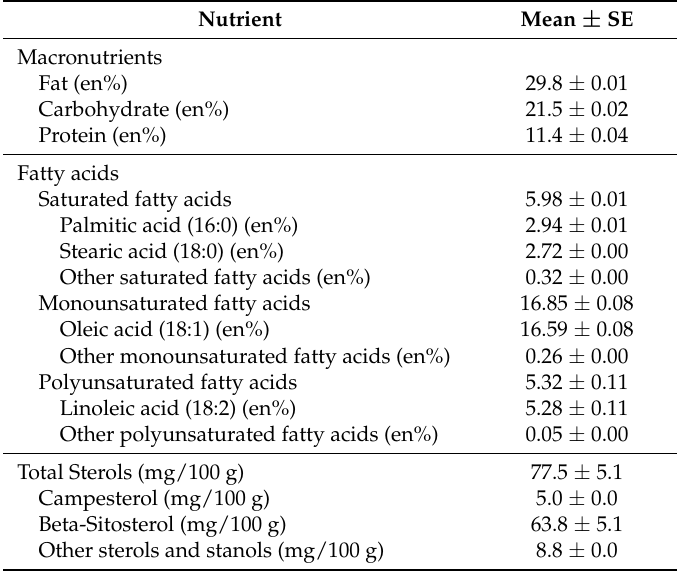
Figure 2. CONSORT (Consolidated Standards of Reporting Trials) diagram for the study of metabolizable energy provided by cashew nuts. Table 1. Characteristics of study subjects prior to the intervention ( n = 18, 9 men and 9 women). Table 2. Analyzed macronutrient, fatty acids, and sterol composition of the cashew nuts. Adapted from